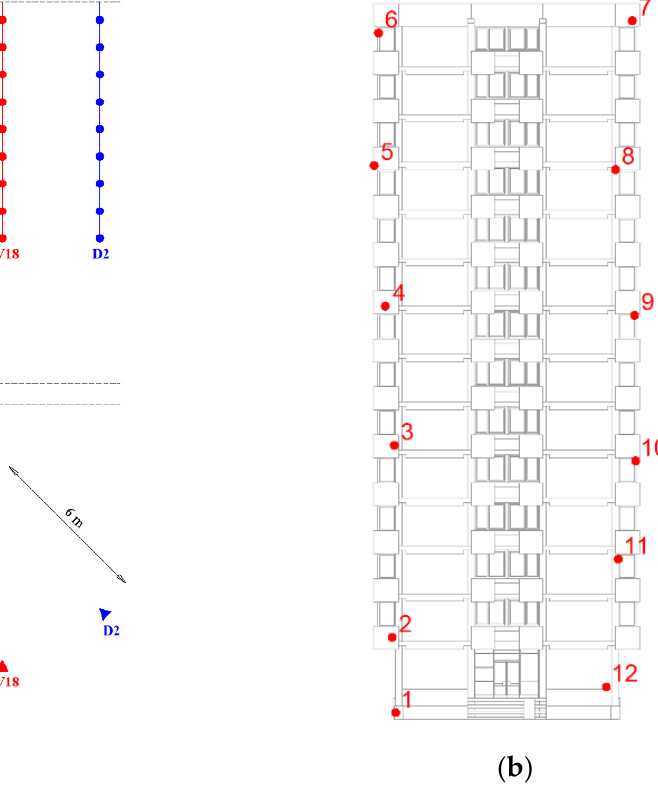
Figure 3. Southeast building façade. ( a ) Flight scheme with image acquisition positions and UAV take-off positions; ( b ) locations of the surveyed control points on the façade.